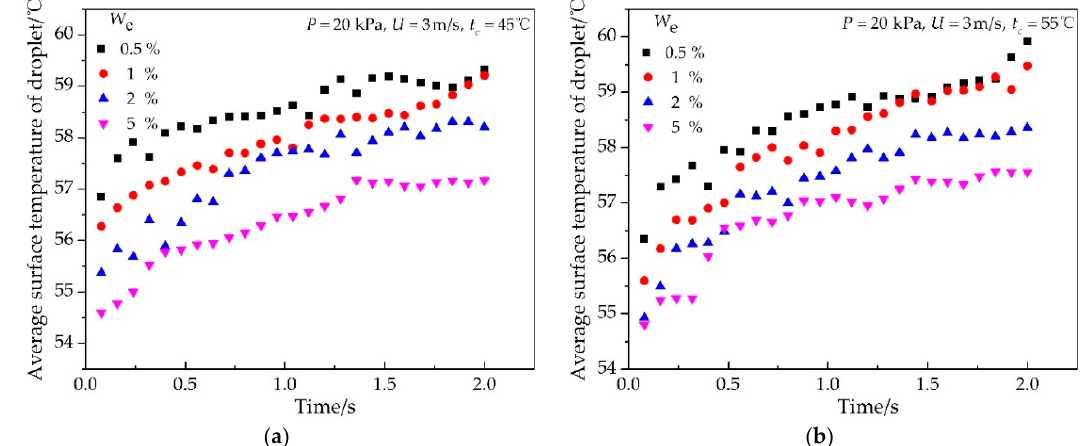
Figure 8. Effect of ethanol vapor concentrations on the average surface temperature of a typical single droplet at different times with the experimental conditions of ( a ) P = 20 kPa, U = 3 m/s, t c = 45 °C; ( b ) P = 20 kPa, U = 3 m/s, t c = 55 °C.